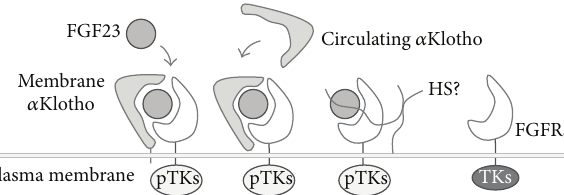
Figure 4: Possible klotho-dependent and klotho-independent mechanisms of FGF23 actions. FGF23 may activate FGFR tyrosine kinases with or without membrane and circulating 𝛼 Klotho. TKs: nonphosphorylated tyrosine